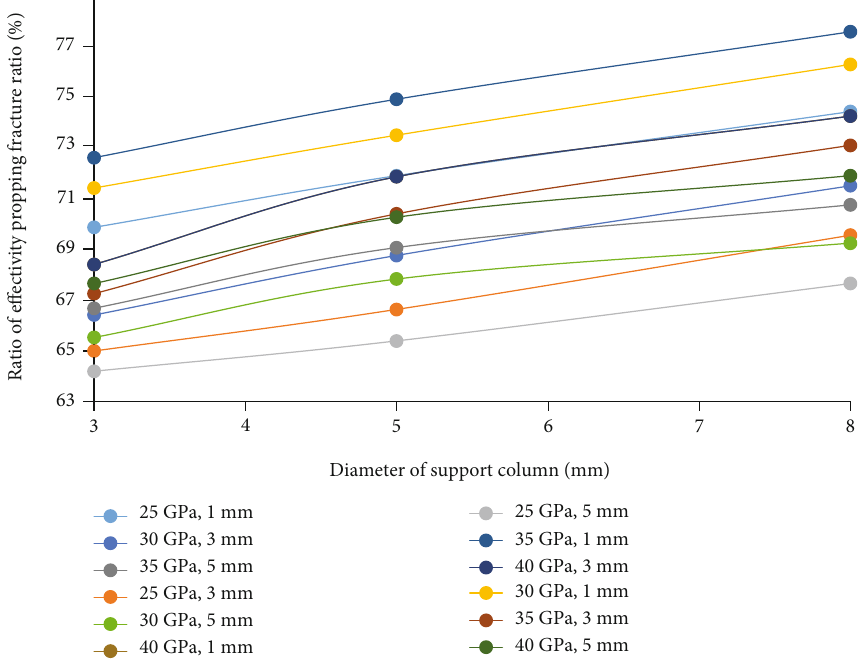
Figure 50: The e ff ect of proppant height on the ratio of e ff ective propped fractures under 50 MPa in situ stress and di ff erent elastic